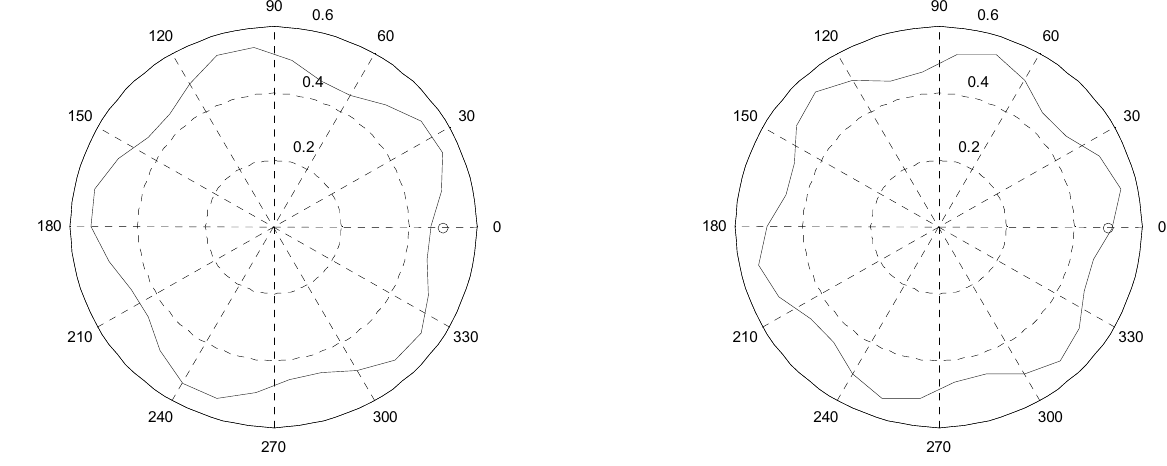
Fig. 9. Mode 5 excited at velocity 43.6 m/s and mode 6 at velocity 44.2